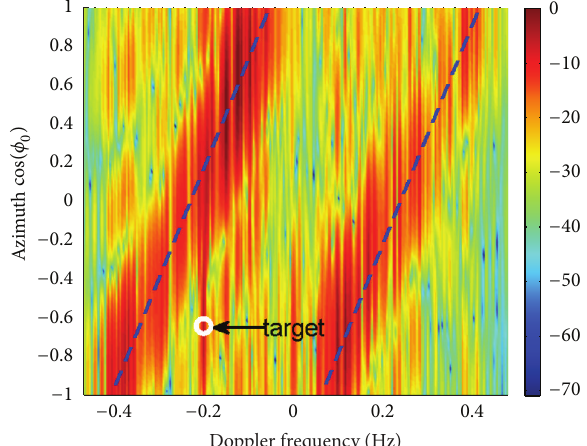
Figure 8: Space-time spectrum with a simulated target (real clutter data file 1057, target azimuth 130 ∘